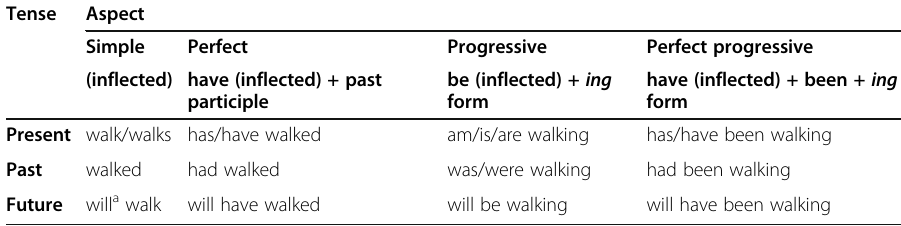
Table. 1 The English tense – aspect system (adapted from Celce-Murcia and Larsen-Freeman (1999) and Larsen-Freeman and Celce-Murcia (2015) Tense Aspect Simple Perfect Progressive Perfect progressive (inflected) have (inflected) + past be (inflected) + ing have (inflected) + been + ing participle form form Present walk/walks has/have walked am/is/are walking has/have been walking Past walked had walked was/were walking had been walking Future will a walk will have